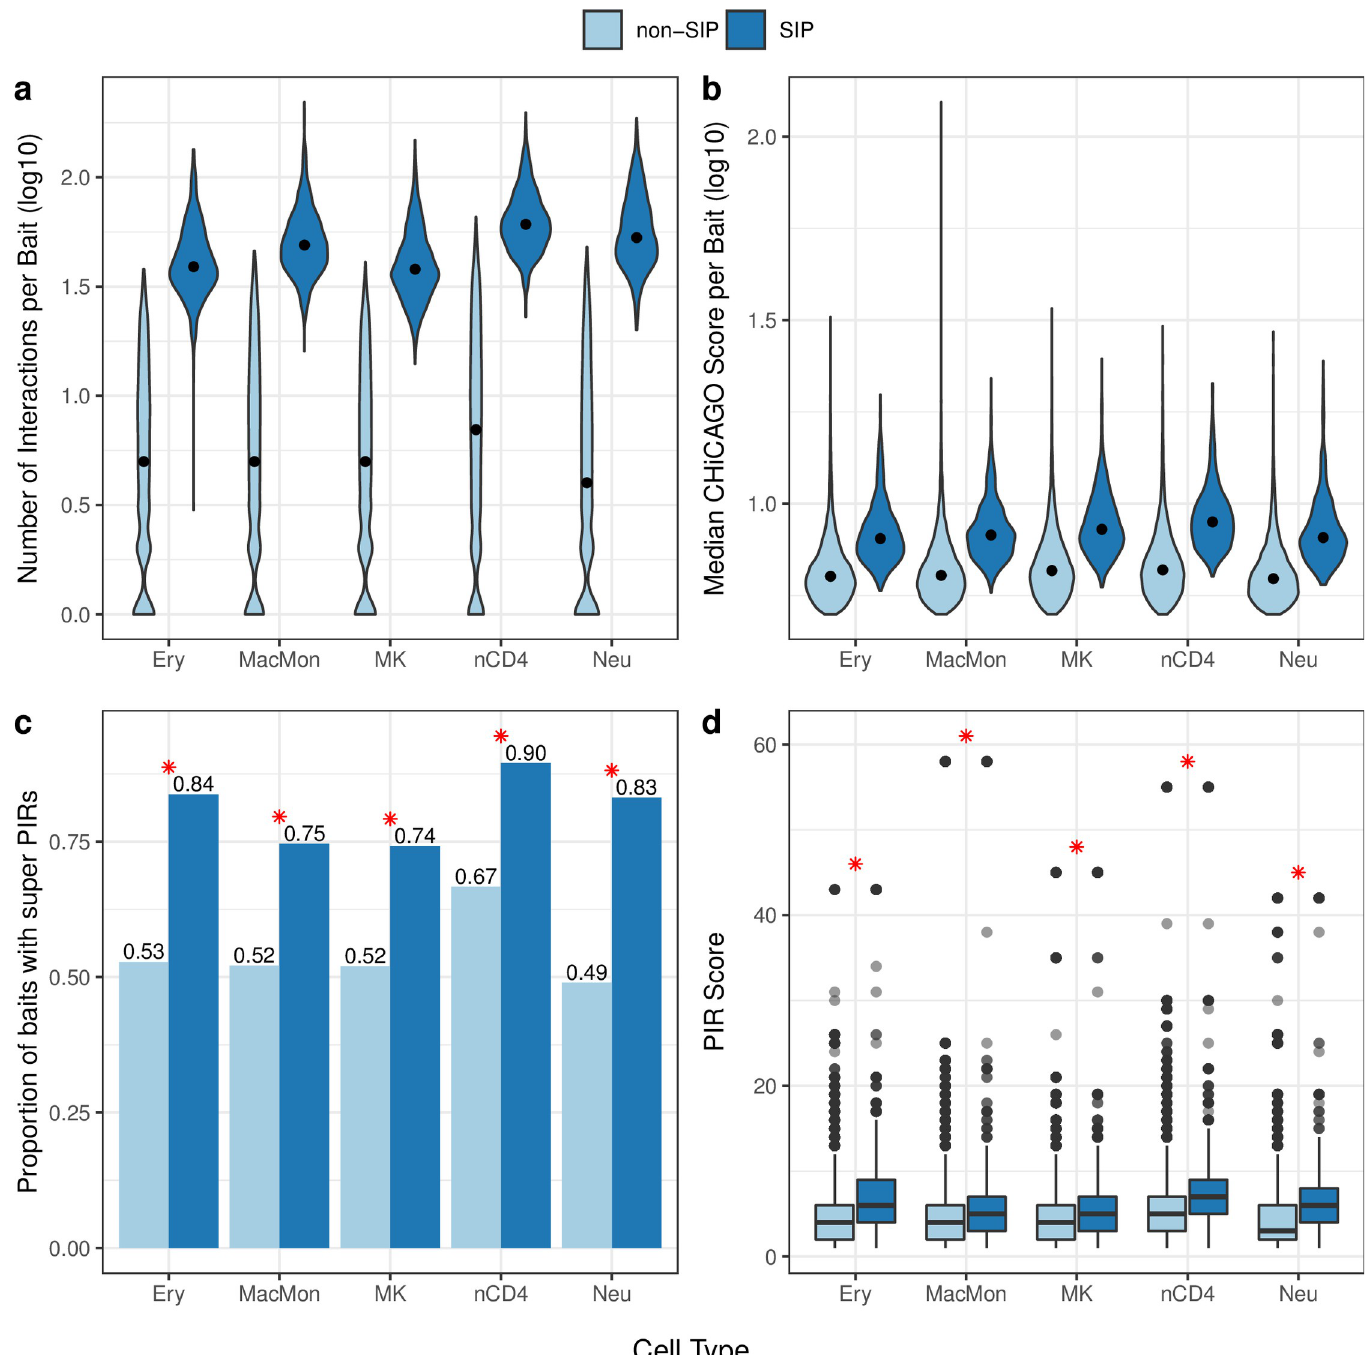
Fig 2. SIPs are driven by a large number of interactions. ( A ) Distribution of the number of significant interactions (log10 scale) between promoter bait and promoter interacting regions (PIRs) for SIPs and non-SIPs in each cell type. ( B ) Distribution of the median CHiCAGO score (log10 scale) of significant interactions per promoter bait for SIPs and non-SIPs in each cell type. The width of each violin corresponds to the frequency of interaction count ( A ) or median CHiCAGO score ( B ). The median of each distribution is marked by a black dot. ( C ) The proportion of SIP and non-SIP baits with super PIRs in each cell type. SIPs interact with a larger proportion of super PIRs than non-SIPs in each cell type (the red asterisk ( � ) denotes Chi-square p -value < 3.2e-35). ( D ) Distribution of PIR scores for SIPs and non-SIPs in each cell type. SIPs have significantly higher PIR scores than non-SIPs in each cell type (the red asterisk ( � ) denotes Wilcoxon p -value < 1.7e-50). Details for panels ( C ) and ( D ) can be found in S1 Table. (Ery = erythrocytes; MacMon = macrophages/monocytes; MK = megakaryocytes; nCD4 = naive CD4 T-cells; Neu = neutrophils).